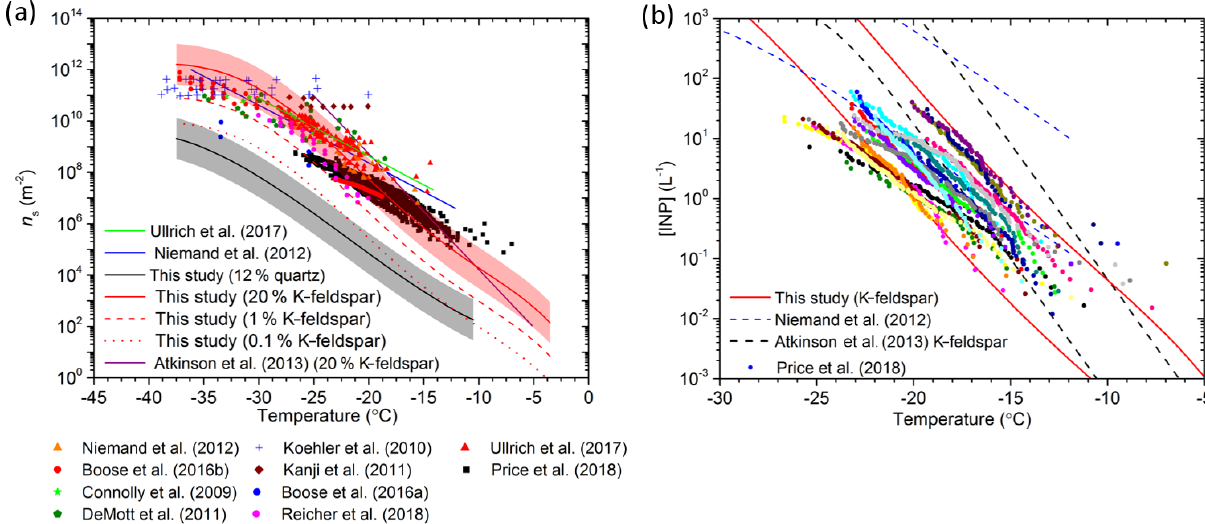
Figure 9. Testing of the newly developed K-feldspar and quartz parameterizations against literature data for desert dust. (a) Comparison of n s versus temperature for mineral dust from laboratory and field studies against the K-feldspar and quartz parameterizations. The red lines are n s values where 0.1%, 1% and 20% of the aerosol surface area is assumed to be K-feldspar. The standard deviation of the K-feldspar parameterization from this study is represented as the shaded area around the 20% K-feldspar prediction; this is to show the natural variability in mineral activity. The prediction for 12% quartz is shown using a black line, with the natural mineral variability of freshly milled quartz highlighted by the shaded region. Literature data and parameterizations have been plotted from Niemand et al. (2012), Boose et al. (2016a, b), Connolly et al. (2009), DeMott et al. (2011), Koehler et al. (2010), Kanji et al. (2011), Reicher et al. (2018), Ullrich et al. (2017), Price et al. (2018). (b) Comparison of the INP concentrations predicted by several parameterizations with the INP concentrations measured in the dusty eastern tropical Atlantic region by Price et al. (2018). The predictions were made assuming that 20% of the dust was K-feldspar, consistent with Kandler et al. (2011). For this calculation we assumed that the dust is externally mixed in terms of its mineralogy, although in this regime an internal versus external mixing state assumption makes very little difference (see Atkinson et al., 2013). The upper and lower bounds of the predicted INP concentrations are based on the lowest and highest aerosol surface area concentrations corresponding to the INP data in Price et al. (2018). Note that the measured INP concentrations from Price et al. (2018) have been corrected downwards by a